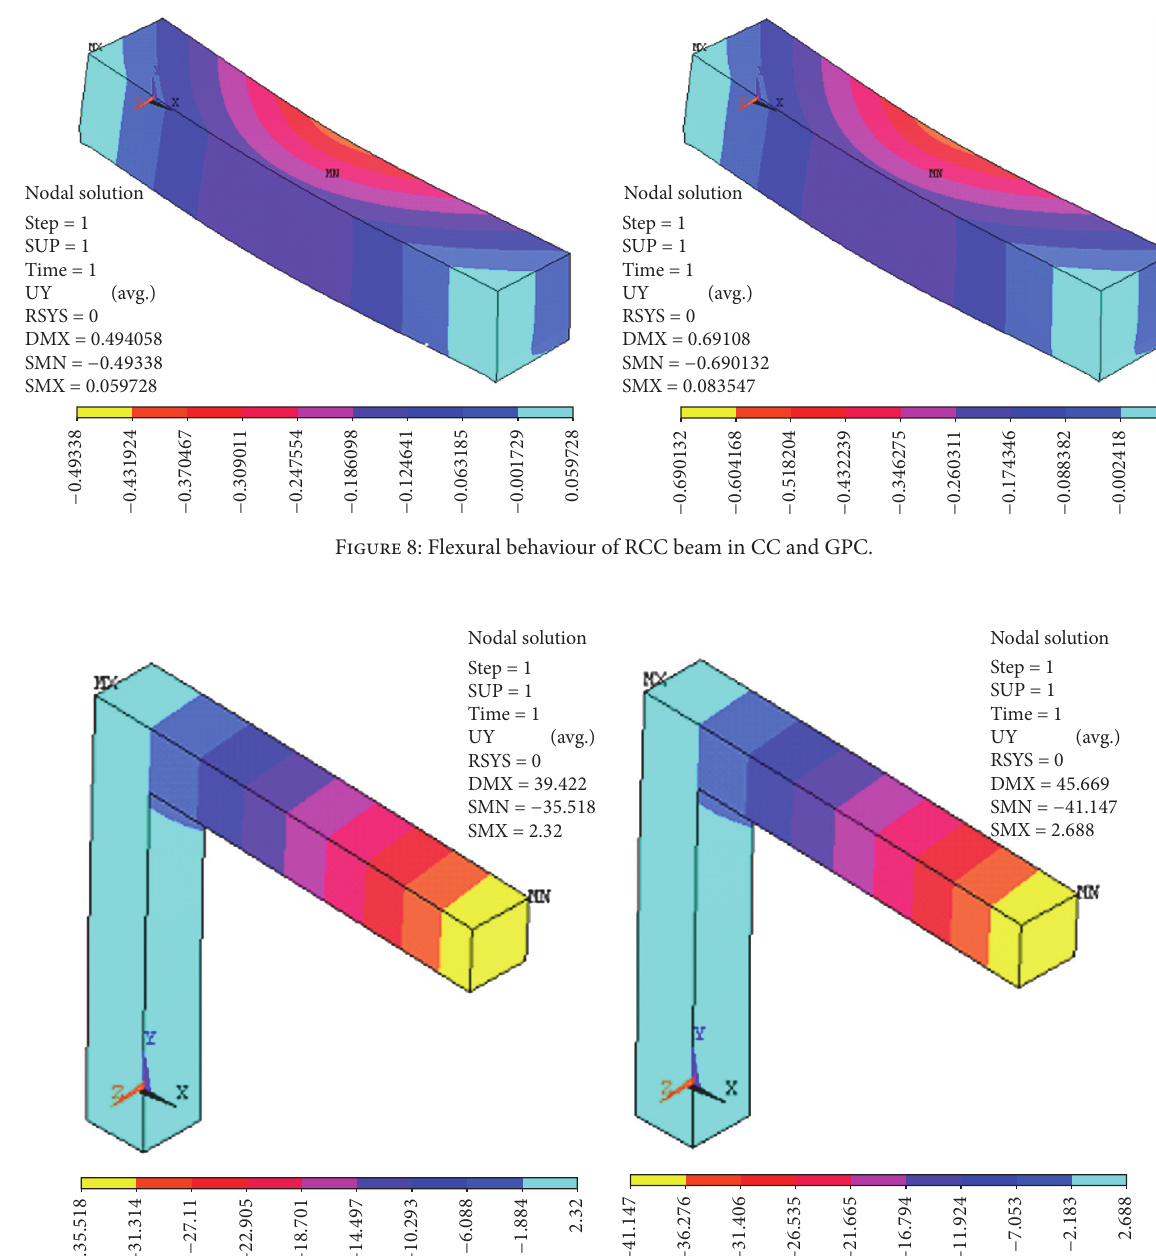
Figure 9: Flexural behaviour of RCC L-beam in CC and